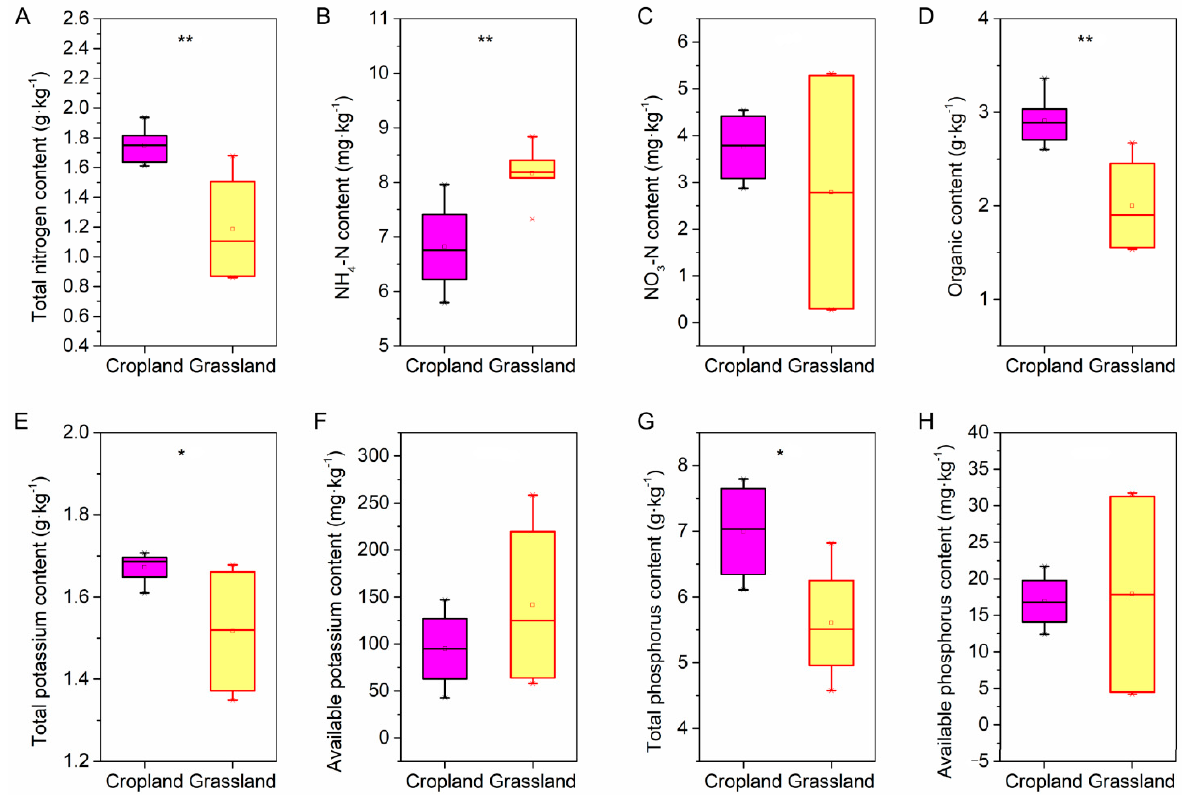
Figure 1. The difference in soil nutrients between cropland and grassland via independent-samples t -test. ( A ) The difference in soil total nitrogen between the cropland and grassland. ( B ) The difference in soil ammonia nitrogen (NH 4 -N) between the cropland and grassland. ( C ) The difference in soil nitrate-nitrogen (NO 3 -N) between the cropland and grassland. ( D ) The difference in soil organic matter between the cropland and grassland. ( E ) The difference in soil total potassium between the cropland and grassland. ( F ) The difference in soil available potassium between the cropland and grassland. ( G ) The difference in soil total phosphorus between the cropland and grassland. ( H ) The difference in soil available phosphorus between the cropland and grassland. ** shows the significant difference at the 0.01 level, and * shows the significant difference at the 0.05 level.